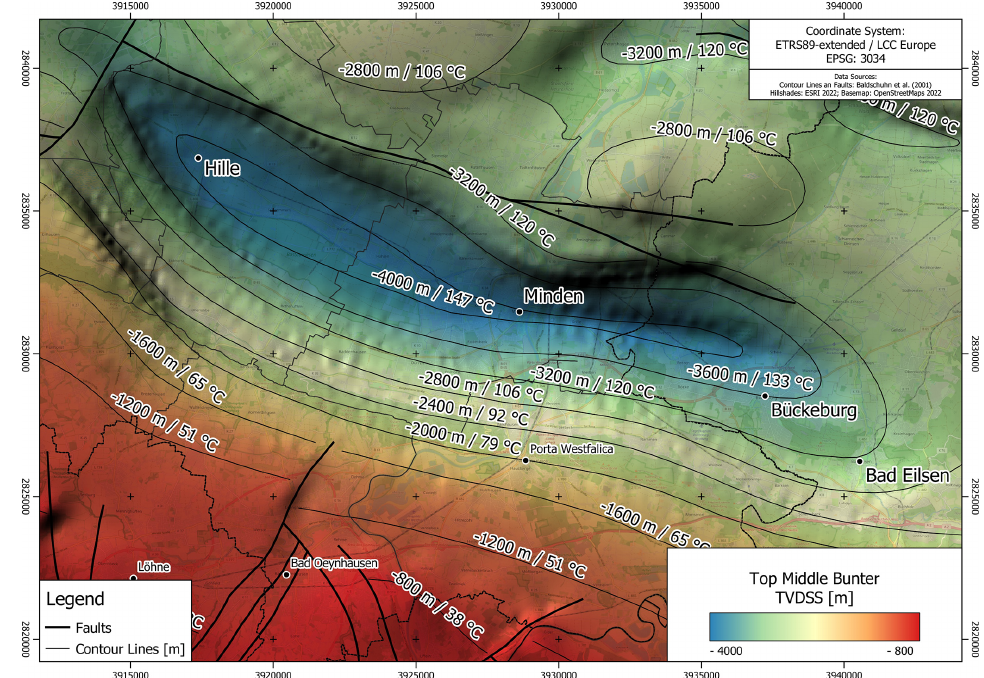
Figure 4. Structural model for the top of the Middle Bunter. The structure of the Weser-Wiehengebirge Syncline is clearly visible. Depths of isolines and associated temperatures according to the average geothermal gradient of d T